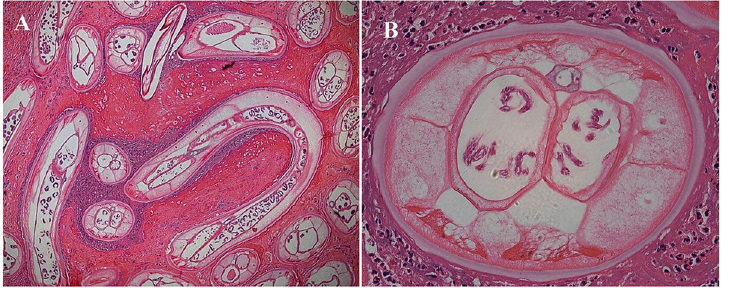
Fig 1. Histopathological examination of the lump after biopsy. Panel A. Hematoxylin and eosin staining shows several adult worms (original magnification × 40). Panel B. Transverse section of a worm (original magnification ×